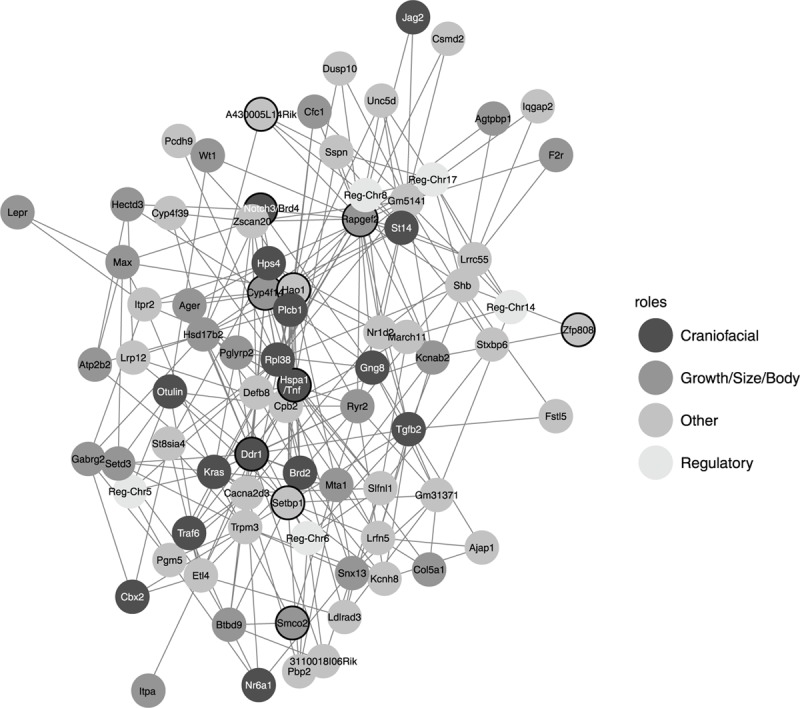
Gene network based on the significant pairwise interactions obtained with the marginal epistasis test. Each node corresponds to the best candidate gene of one marker and its color represents the function of that candidate gene: candidate genes found in MGI HMDC databases for “Craniofacial” and “Growth/size/body” functions are classified in these two groups, the rest of protein-coding genes are labeled as “Other” and those genes that are not protein-coding are classified as “Regulatory.” Black circles correspond to candidate genes with high centrality measures and are discussed in the main text.